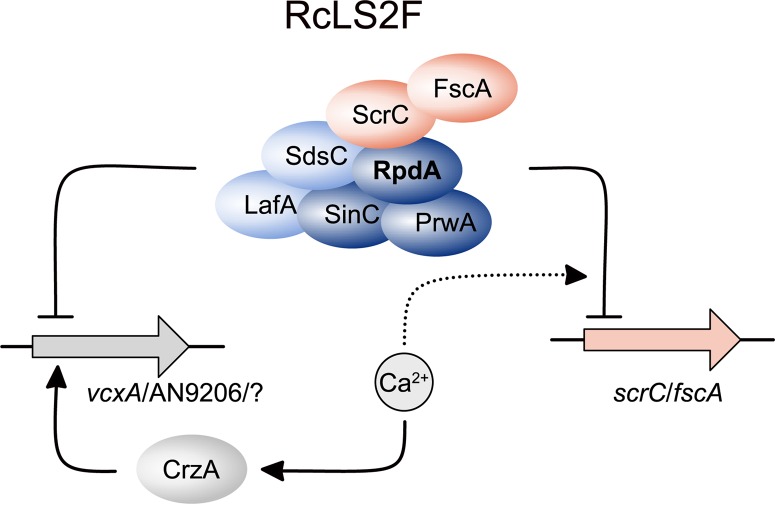
Schematic depiction summarizing the role of RcLS2F in autoregulation and repression of CrzA-dependent genes. Proteins are displayed as ellipses, genes as filled arrows. Lines with arrow heads and barred ends indicate activation and inhibition, respectively. Dashed lines with arrow heads and barred ends display positive and negative influence on regulatory events, respectively.